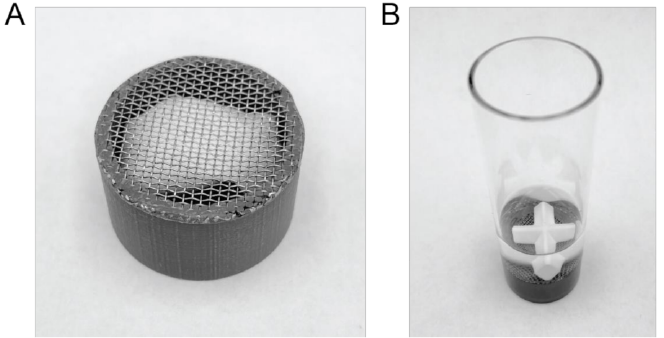
Figure 1. Details of the µ DISS Profiler™ experimental setup. ( A ) An OTDN pouch loaded in the custom-made sinker, 3D printed using polylactic acid (PLA) and fitted with a 20-mesh stainless steel sieve. The sinker measures 12 mm in height and 21 mm in width. ( B ) A snus pouch loaded in the custom-made sinker and placed on the bottom of the standard 20 mL µ DISS Profiler™ dissolution vessel containing 10 mL of artificial saliva with a 20 mm cross-shaped magnetic stirrer on